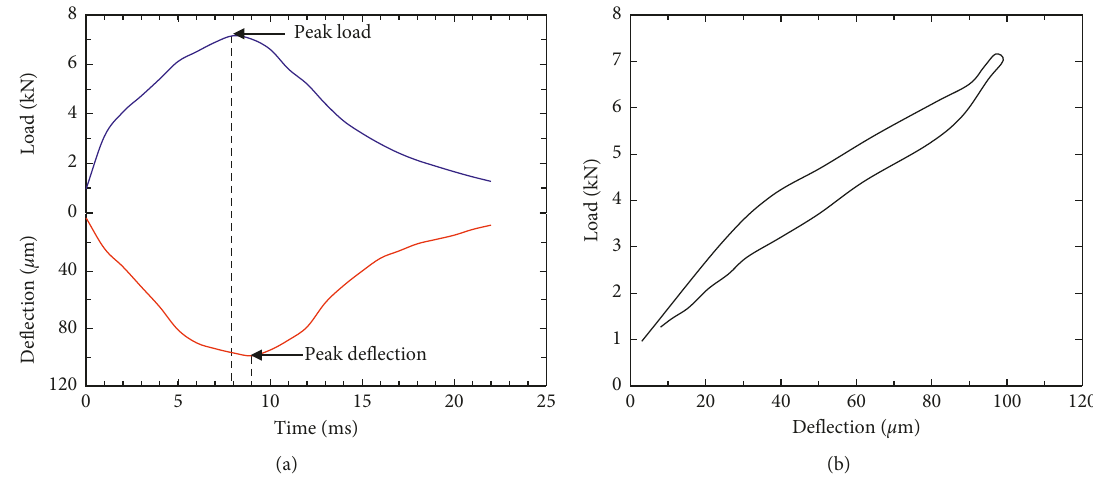
Figure 5: PFWD results for U4. (a) Load and deflection time-history curve. (b) Load-defection